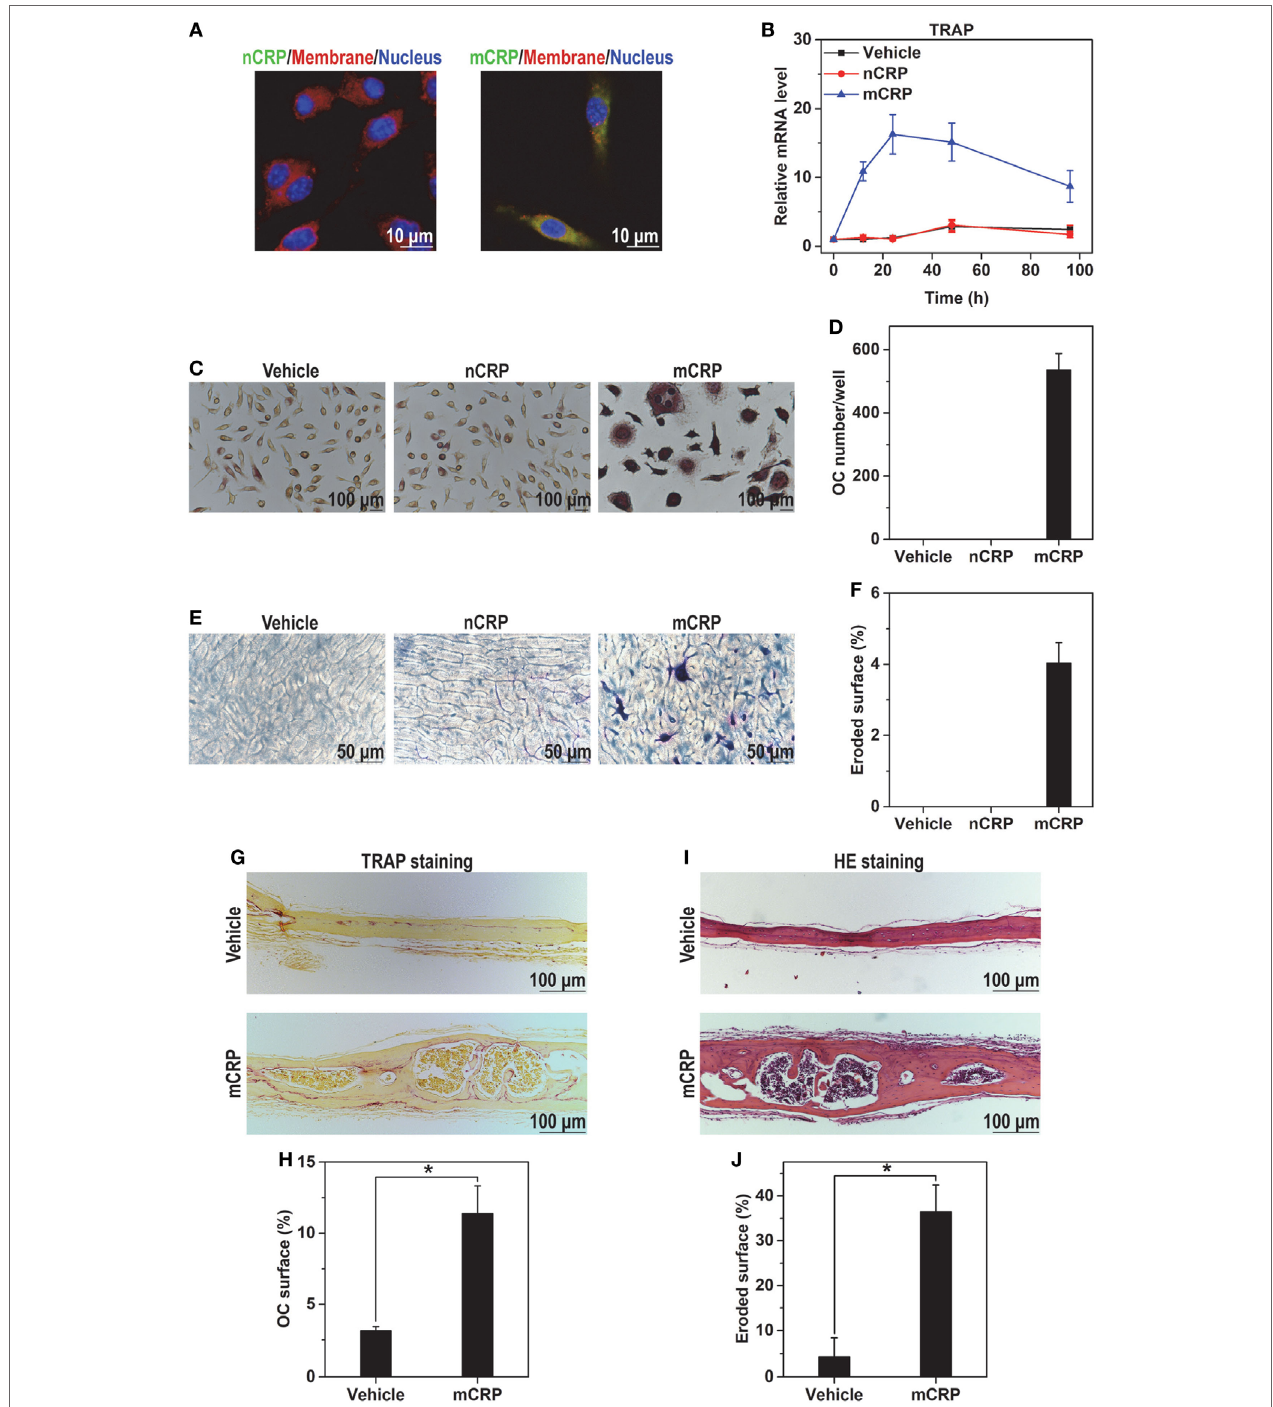
FigUre 2 | mCRP but not native C-reactive protein (nCRP) induces osteoclast differentiation of bone marrow-derived macrophages (BMDMs) and in mice. (a) FITC-labeled nCRP or mCRP was incubated with BMDMs at 4°C and visualized by confocal microscopy. Cell membranes and nuclei were counterstained with FM-4-64 and DAPI, respectively. mCRP bound BMDMs strongly, while nCRP did not. (B) BMDMs were treated with 100 µg/ml nCRP or mCRP for the indicated times. TRAP expression was induced by mCRP but not nCRP. BMDMs were treated with 100 µg/ml nCRP or mCRP for 6 days, and then stained for TRAP (c) to count the number of TRAP-positive multinucleated cells as osteoclasts (D) . BMDMs were plated on bone slices and treated with nCRP or mCRP for 6 days. The slices were then stained by toluidine blue (e) to measure eroded surface (F) . mCRP but not nCRP induced the differentiation of BMDMs to mature osteoclasts with bone resorption activities. mCRP (2.5 mg/kg) or saline buffer (Vehicle) was s.c. injected on calvaria of healthy wild-type mice every 2 days for 1 week. TRAP (g,h) and hematoxylin and eosin staining (i,J) were conducted to evaluate osteoclastogenesis and bone damage, respectively. Osteolysis was actively induced by mCRP